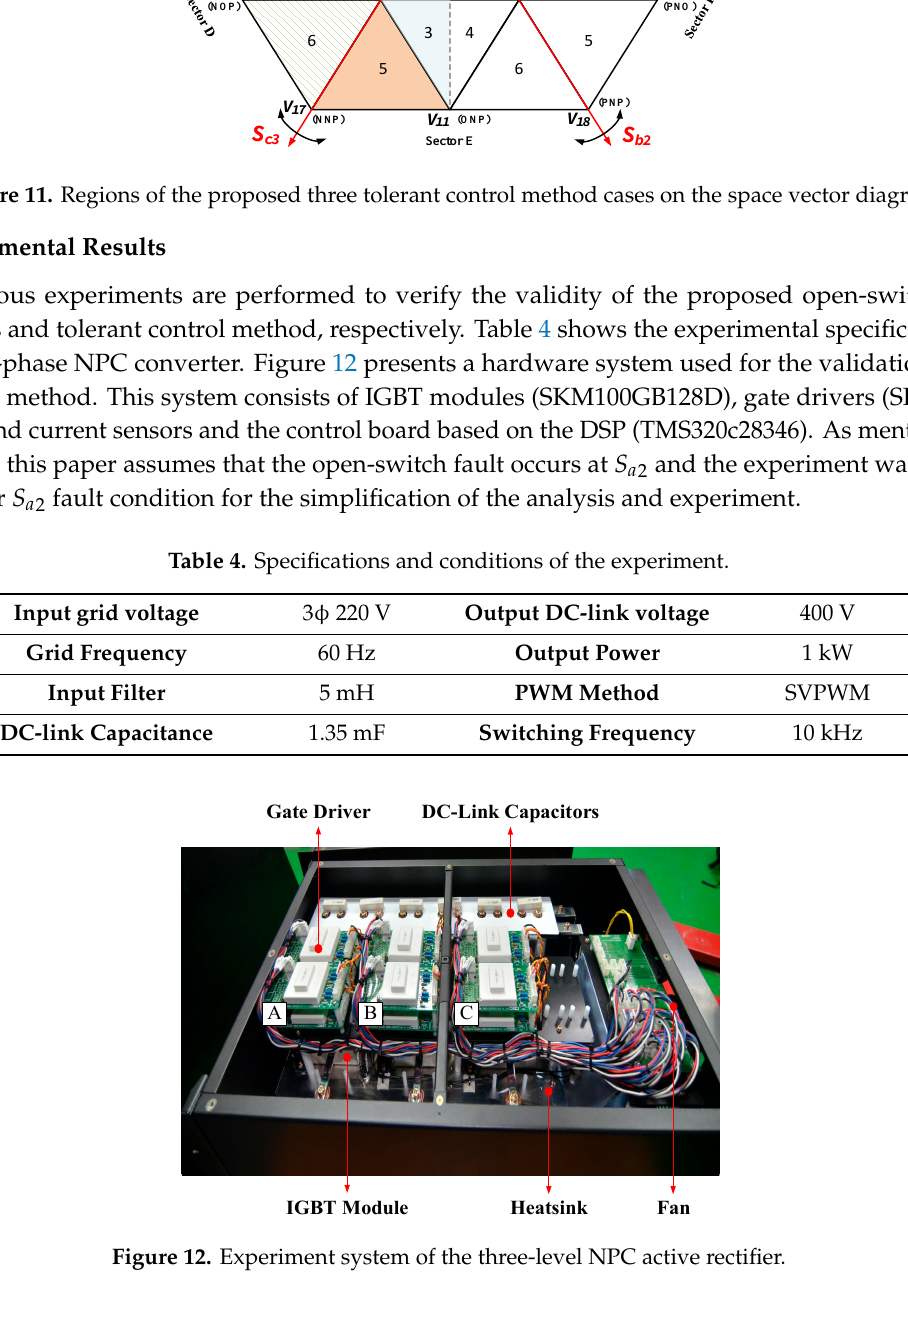
Table 4. Specifications and conditions of the experiment.